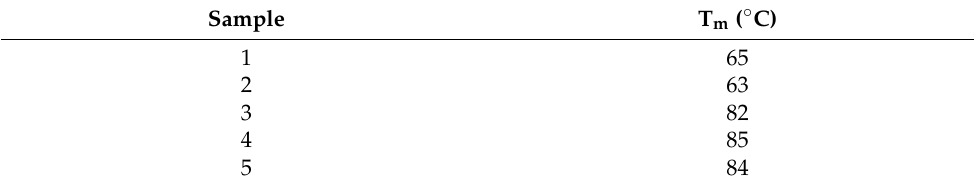
Table 2. Melting temperatures of all samples evaluated by DSC.